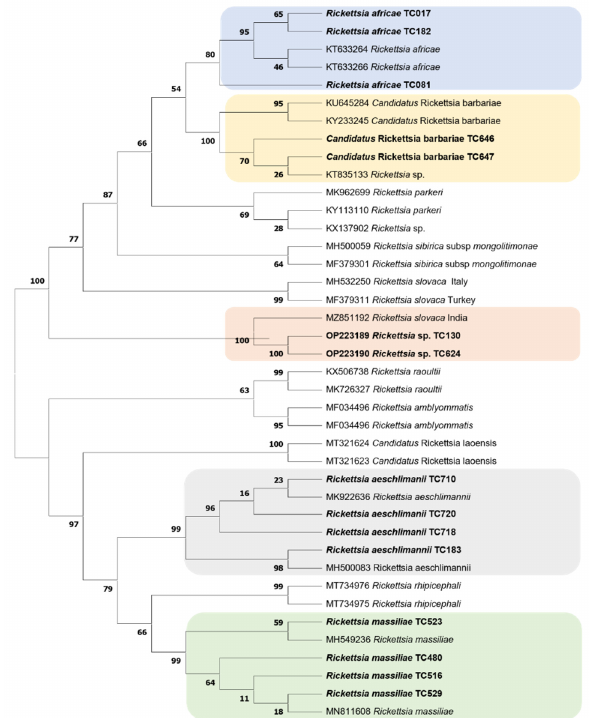
Figure 2. Phylogenetic tree of Rickettsia species detected in ticks from the Western Highlands of Cameroon and constructed by maximum likelihood method. Partial sequence of ompA gene from ticks collected in 2018 were aligned. Microorganisms sequenced in the current study are in bold.